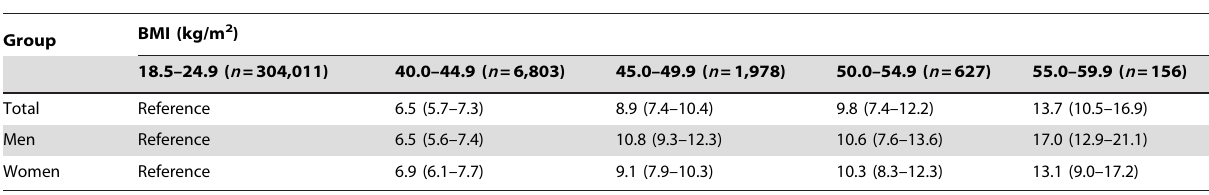
Table 7. Years of life lost and 95% confidence intervals by BMI